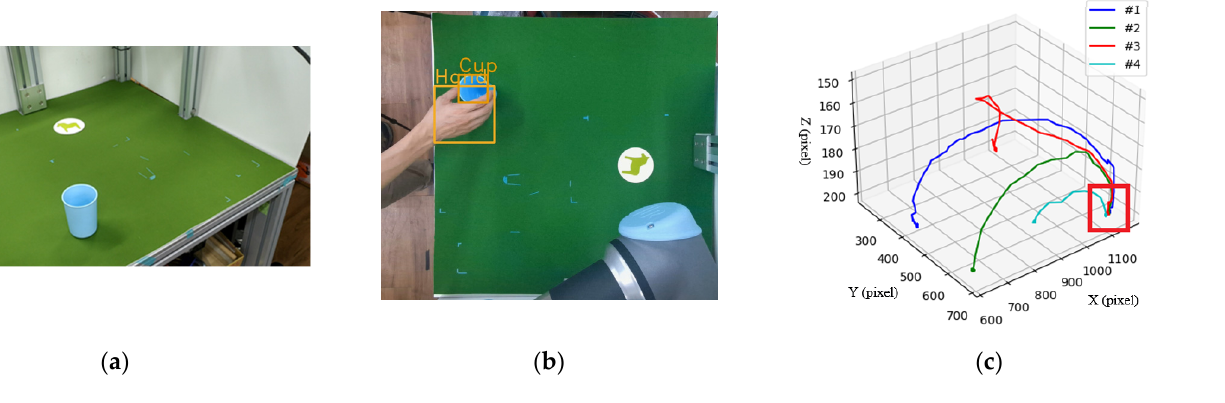
Figure 10. Scenario 1: “pick & place a cup to a fixed position”. ( a ) Experimental environment; ( b ) object detection results; ( c ) absolute trajectory (type-1) of the cup through four demonstrations to induce a key path indicated by a red box.